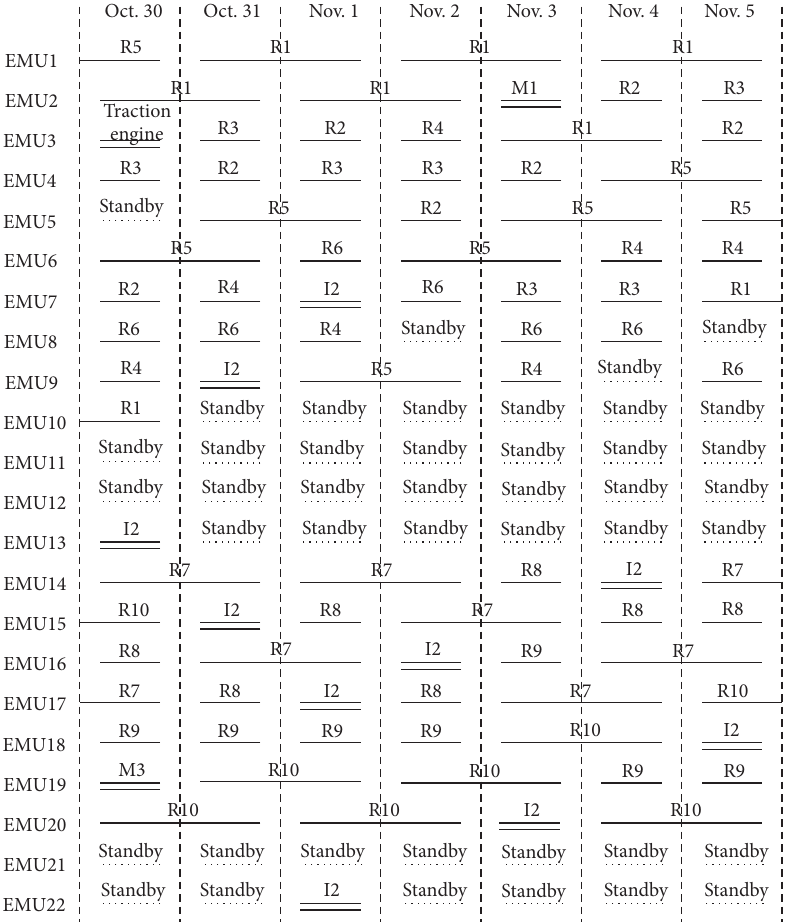
Figure 4: A quasi-optimal motor train set assignment and maintenance